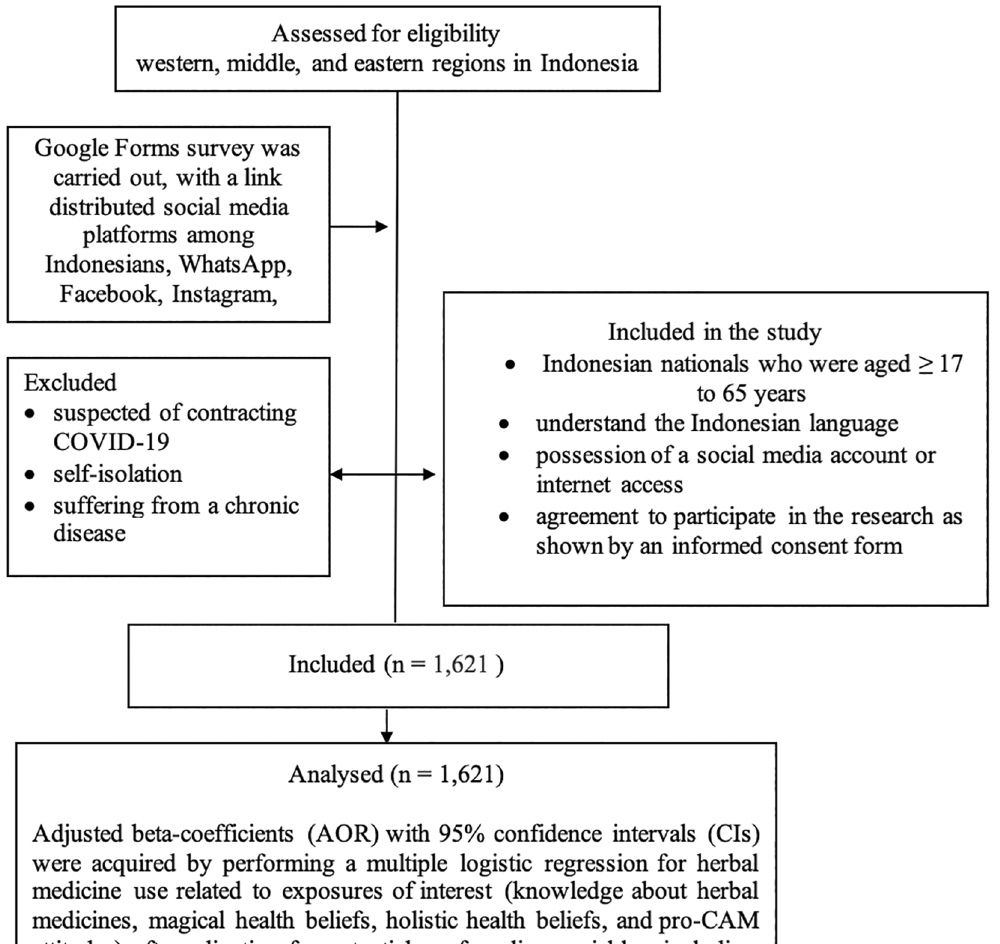
Figure 1. Methodology summarized of this